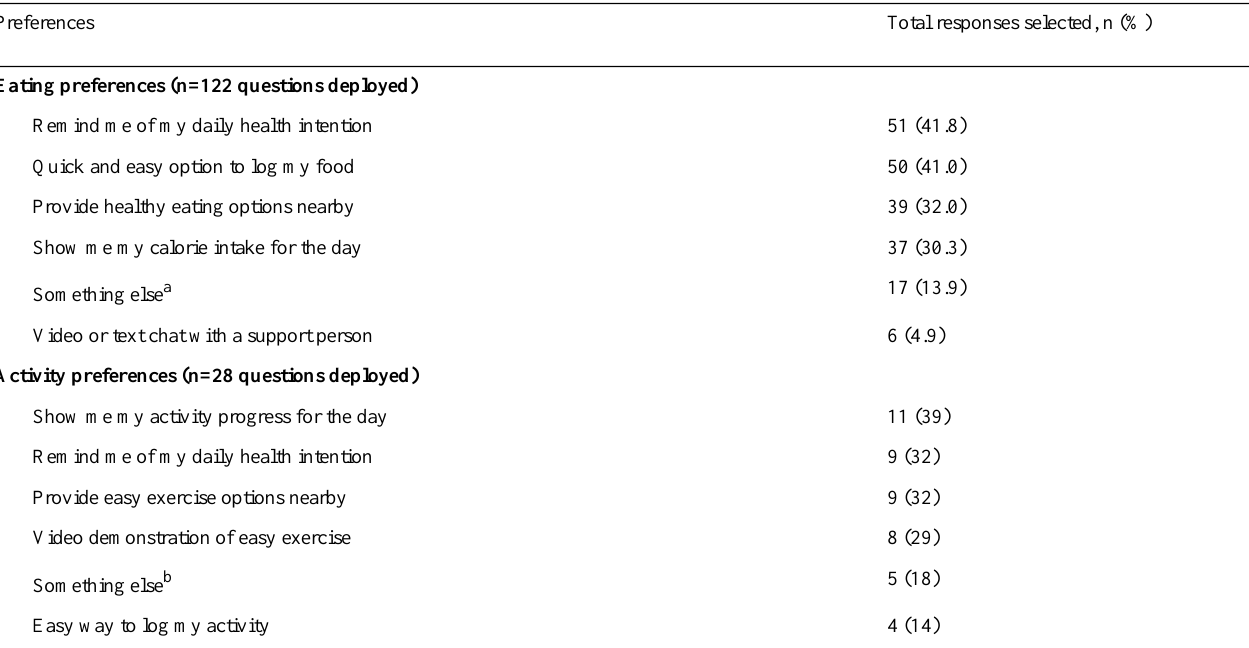
Table 1. Pooled user needs and preferences for healthy eating and activity.